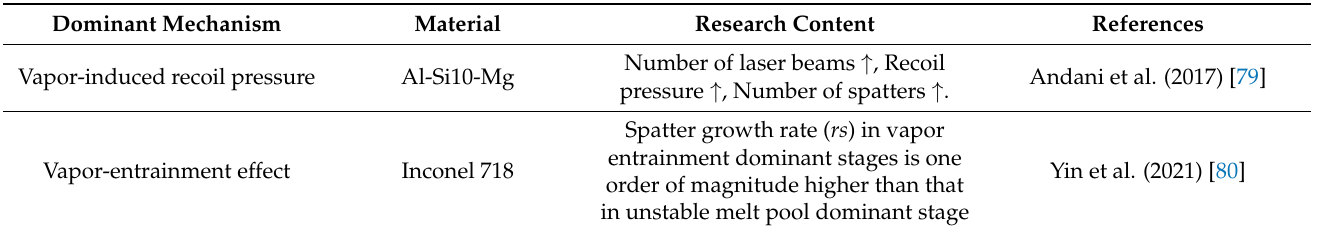
Figure 13. Schematic diagram of the transformation of the main mechanisms of spatter generation, which changes from ( a ) the vapor-induced recoil pressure with an almost homogeneous distribution of spatter ejection angle, into ( b ) the vapor-induced entrainment that majority of spatters eject along the direction of the metal vapor propagation. (Reprinted with permission from Ref. [80]. Copyright 2021 Elsevier B.V.). Table 6. A summary of the studies on the mechanism of spatter generation during ML-PBF process.